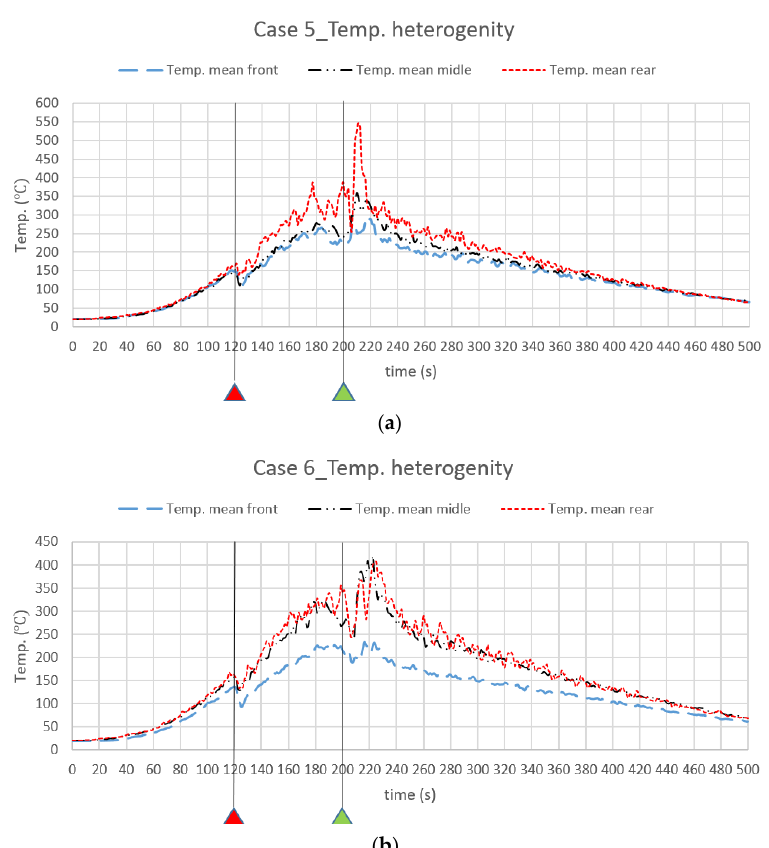
Figure 10. ( a ) Influence of partition wall on temperature heterogeneity with same ventilation condi- tions; case 5 without partition wall (e.g., cases 5 and 6). ( b ) Influence of partition wall on temperature heterogeneity with same ventilation conditions; case 6 with partition wall (e.g., cases 5 and 6). The outcome of the field model showed good agreement with Toxfire’s (a), Dalmar- nock’s (b), and the Columbia UL Fire Safety Research Institute’s (c) fire test results: (a) There was agreement that the HRR value decreased as the ventilation factor de- creased; under ventilated conditions, this caused the HRR maximum to be below the assumed data. The HRR did not increase due to the enclosure’s geometry and venti- lation because of the radiation impact [21]; (b) There was further agreement in terms of the temperature heterogeneity of the enclo- sure [22]; (c) Finally, there was agreement that the enclosure’s fires generated a fuel-rich environ- ment [23]. Some agreements arose due to experiments having unplanned realistic fire condi- tions, such as the unplanned breakage of windows or changes in the enclosure’s geometry. 5. Conclusions The computations were not intended to model a specific scenario but rather to model an enclosure fire and focus on the effect of variations in the ventilation and geometry. The standard test methods have the advantage of representing a worst-case scenario for a single element of construction, but they present a disadvantage in terms of the rep- resentation of a real fire in the enclosures. There is a significant difference between real-situation fires and experiments carried out in specially designed rooms inside a shielded environment. The material data used for a well-ventilated condition will not apply due to changes in the ventilation factor and the enclosure’s geometry. There is a need for better optimization of the experiments, as they will eventually require a more realistic set-up. Fire safety science needs to shift from using simplified models to field models that are more representative of a real fire and implement a perfor- mance-based approach for fire engineering. This approach will increase the safety of building occupants and fire emergency personnel and reduce the costs of fire protection and the construction of buildings. Further research is required to generate a better understanding of the process of cold air injection into an enclosed space and how to entrain smoke and the flow of a deficient mixture of oxygen to the base of a fire.